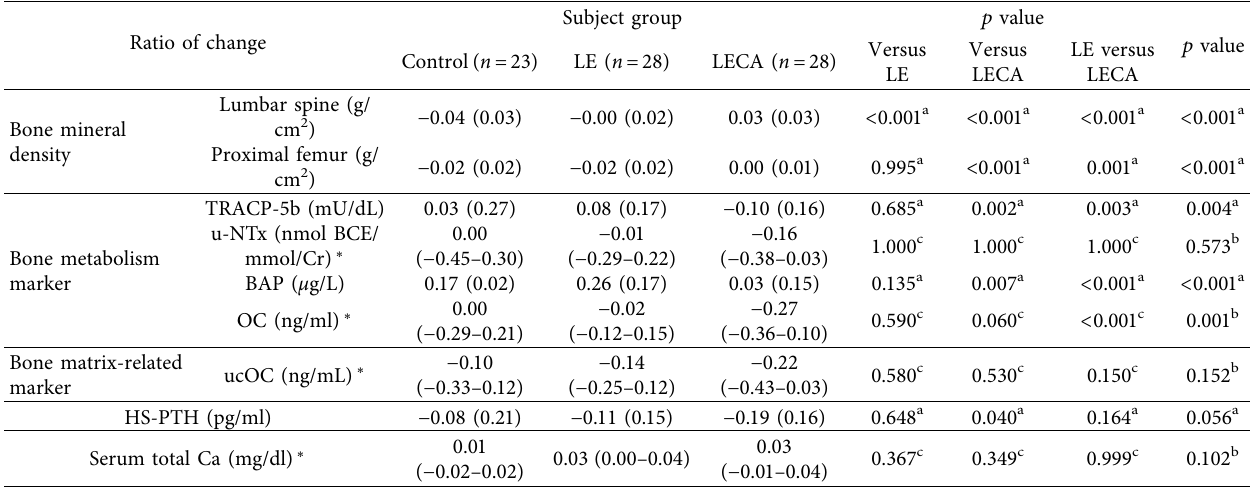
Table 4: Ratio of change after 11 months of intervention.